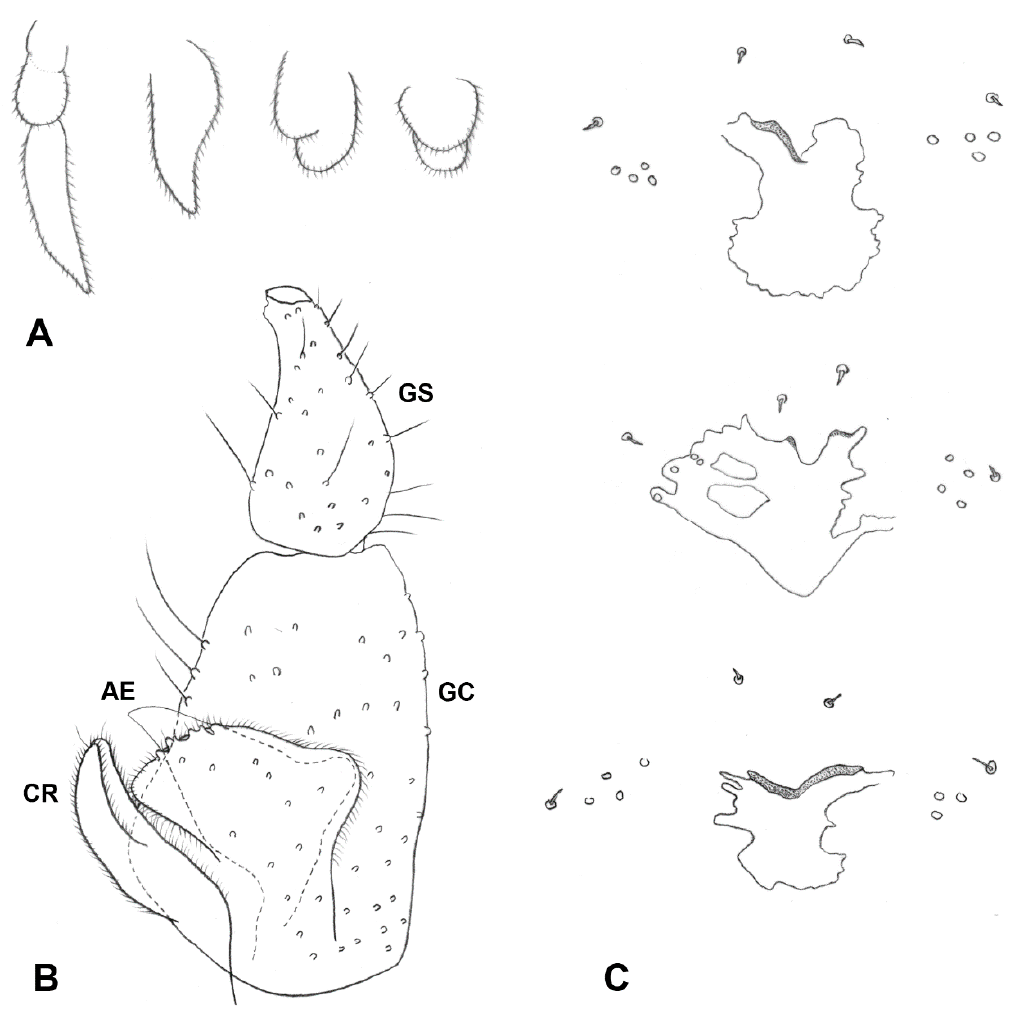
Figure 12. Ruschiola namaqua . ( A ) Variation in palpus morphology. ( B ) Male terminalia, lateral. ( C ) Variation in shape of spatula and associated papillae. AE: aedeagus; CR: cerci; GC: gonocoxite; GS: gonostylus.